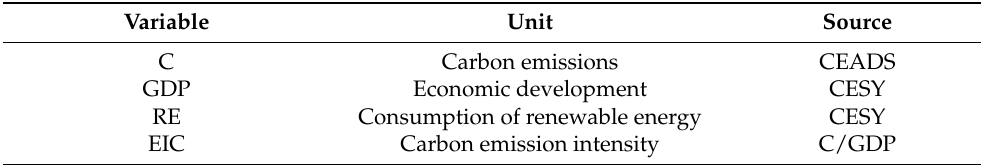
Table 1. Description of data and